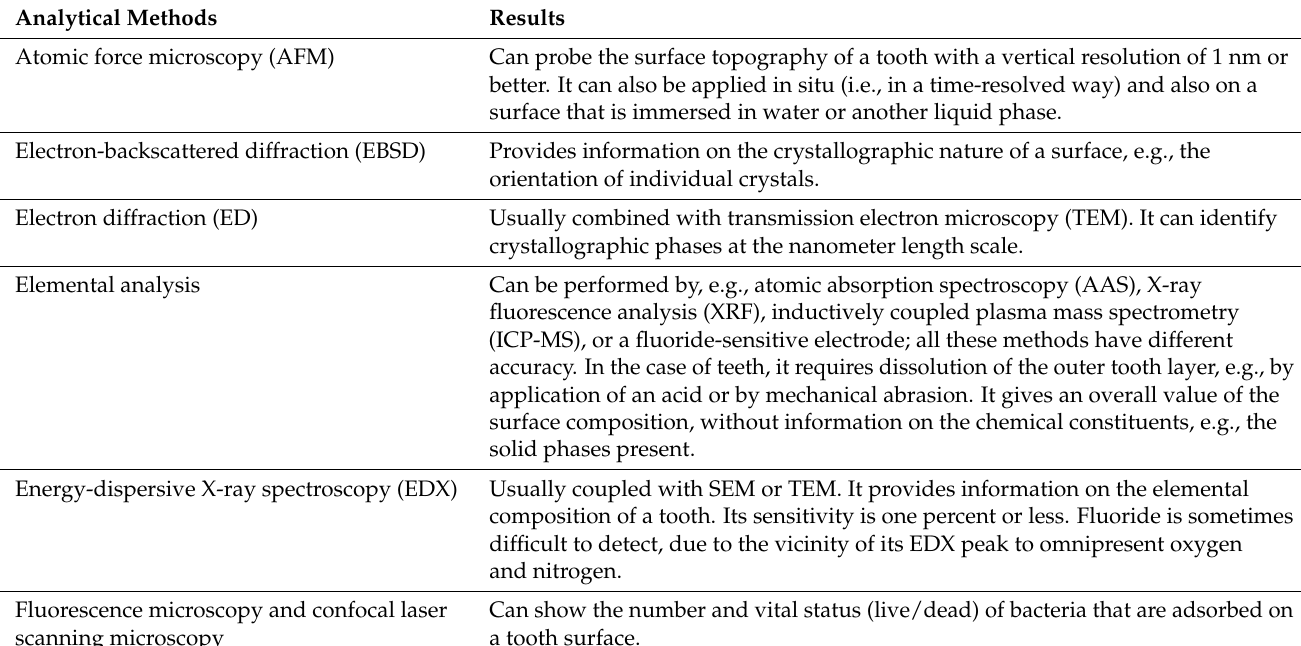
Table 1. Overview of methods for analyzing tooth surfaces (ordered alphabetically). All methods work with extracted human teeth as well as with bovine teeth; however, they are not applicable directly in the oral